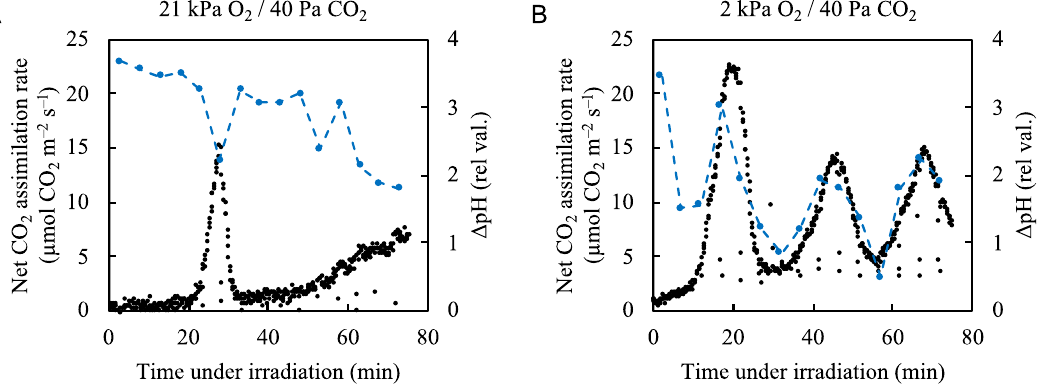
Figure 6. E ff ects of partial pressure of O 2 on the relationship between the net CO 2 assimilation rate and ∆ pH across thylakoid membranes in rice leaves. The ∆ pH across thylakoid membranes (blue circles) was measured simultaneously with the net CO 2 assimilation rate (black circles) under ( A ) 21 kPa O 2 / 40 Pa CO 2 and ( B ) 2 kPa O 2 / 40 Pa CO 2 conditions. Actinic light (700 µ mol photons m –2 s –1 ) was turned on at 0 min. Dashed blue lines in the graph were arbitrarily drawn to indicate the trend of the data.